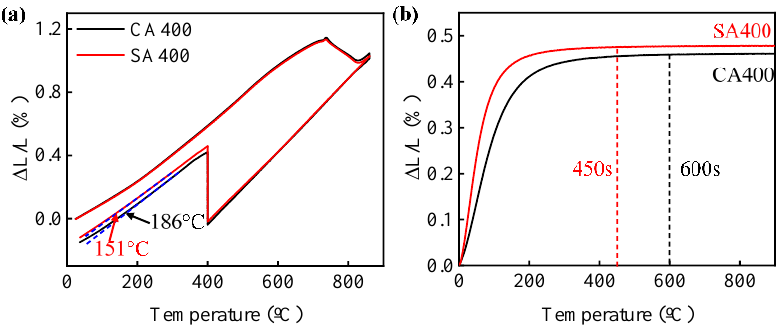
Figure 4. ( a ) The relative change in length of dilatometry samples with temperature during heating, cooling, and isothermal holding processes; ( b ) the expansion curves of bainitic transformation during austempering at 400 °C.